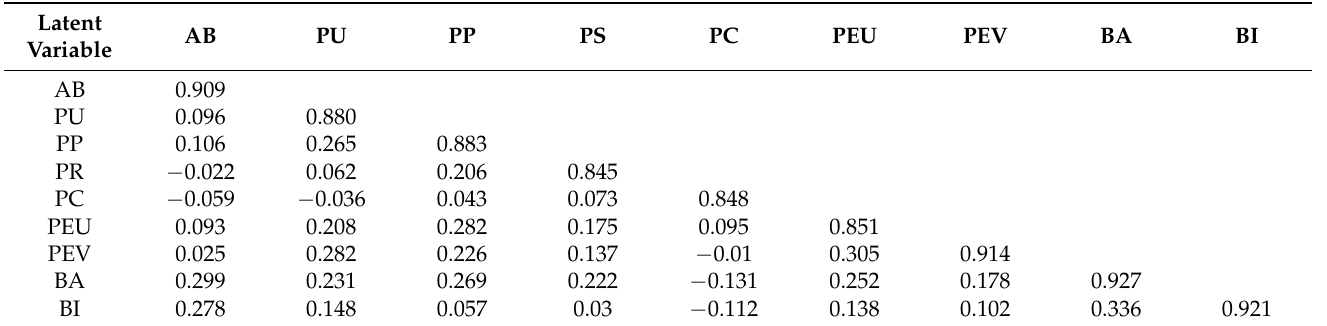
Table 6. Discriminant validity matrix (Fornell and Larcker criterion).